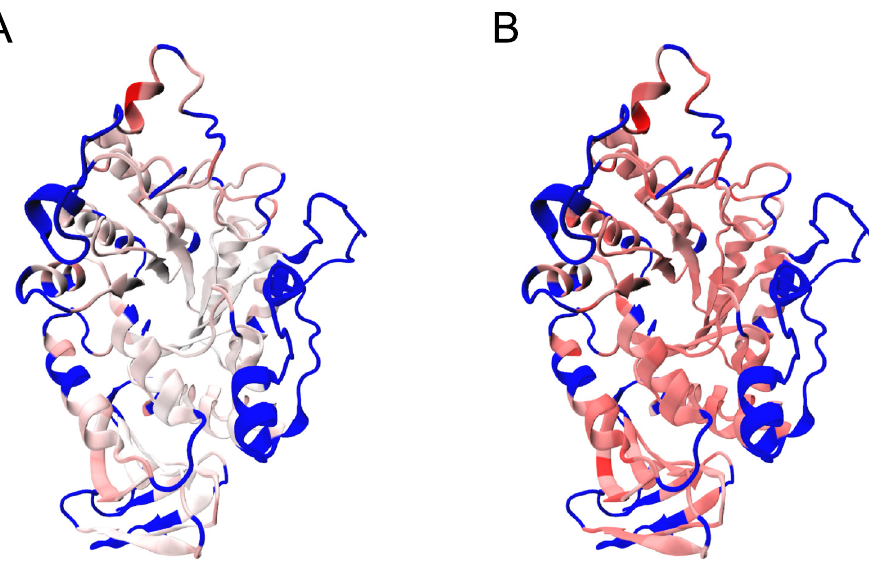
P Fig 1. j b j rendered in the source structure 4E2O. White represents the lowest magnitude (0), while red the l i i ¼ x ; y ; z highest (1). Blue depicts the non-homologous residues. A. Selection gradient on G . B. Dynamic gradient on M